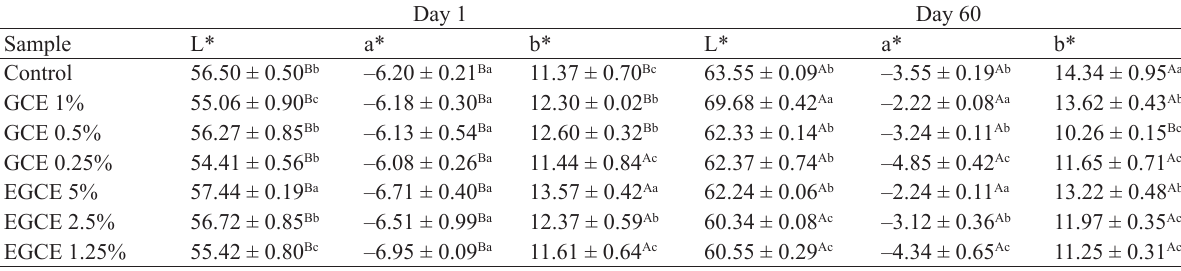
Table 5 Color characteristics of kashk samples with GCE on day 1 and day 60 Day 1 Day 60